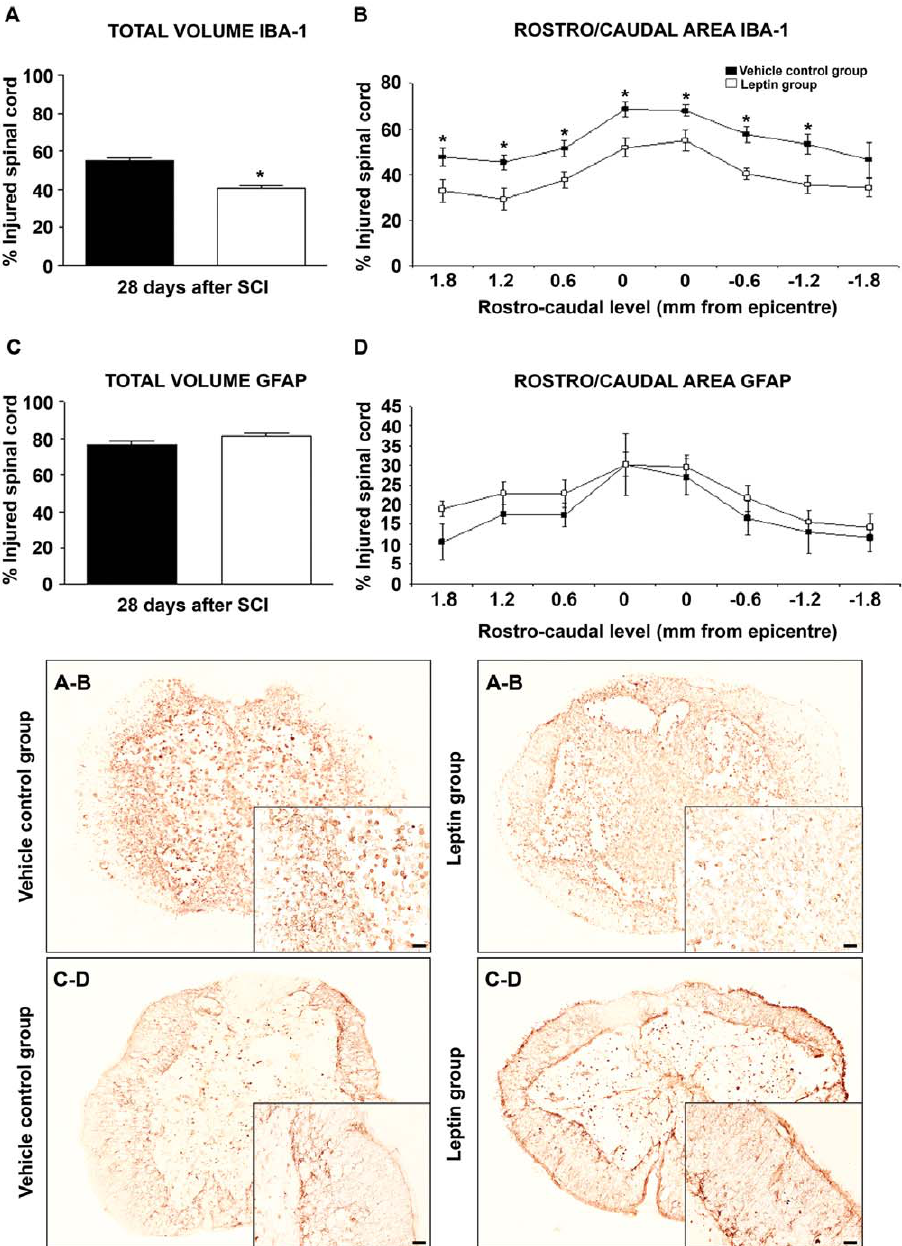
Figure 9. Leptin administration decreases microglial/macrophage activation but has no effect on astroglial reactivity. Leptin administration significantly diminished the presence of Iba1 + microglia/macrophages when compared with vehicle treated controls, as measured by the total volume occupied by Iba1 + microglia/macrophages (A) and the area occupied at multiple rostro-caudal levels (B). No differences between groups were observed in the total volume occupied by GFAP + astrocytes (C) or the area occupied at each rostro-caudal level (D). The values represent the mean 6 SEM; * p , 0.05 versus the vehicle-treated control group. Scale bars=50 m m.